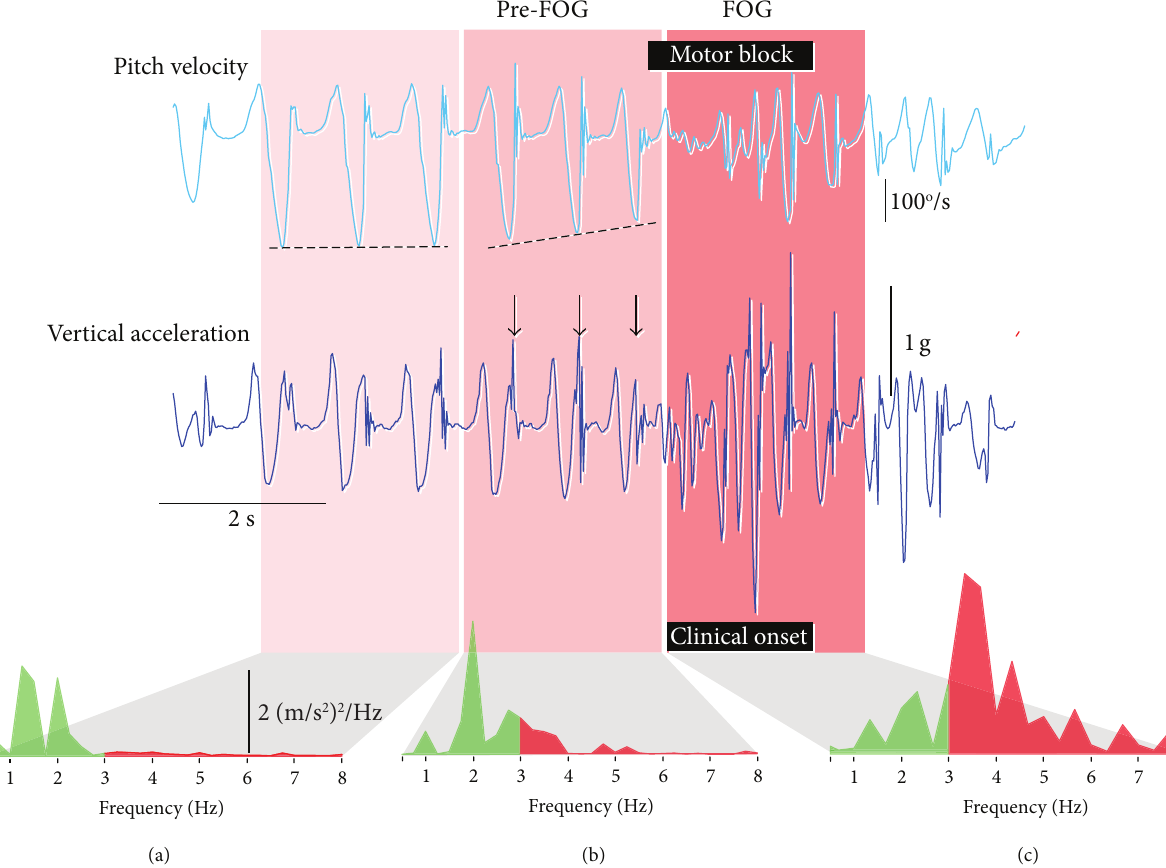
Figure 3: Development of high frequency lower limb oscillation prior to and during FOG. (a) Four to six strides prior to freezing, stride (peak swing phase velocity) was consistent and little power was observed in the 3–8 Hz band. (b) In the three strides prior to FOG, peak swing phase velocity (and therefore stride length) successively decreased and high frequency oscillations developed at heel strike, reflected in growing power in the 3–8 Hz band. (c) During FOG, forward progression had ceased and high frequency oscillations dominated the frequency